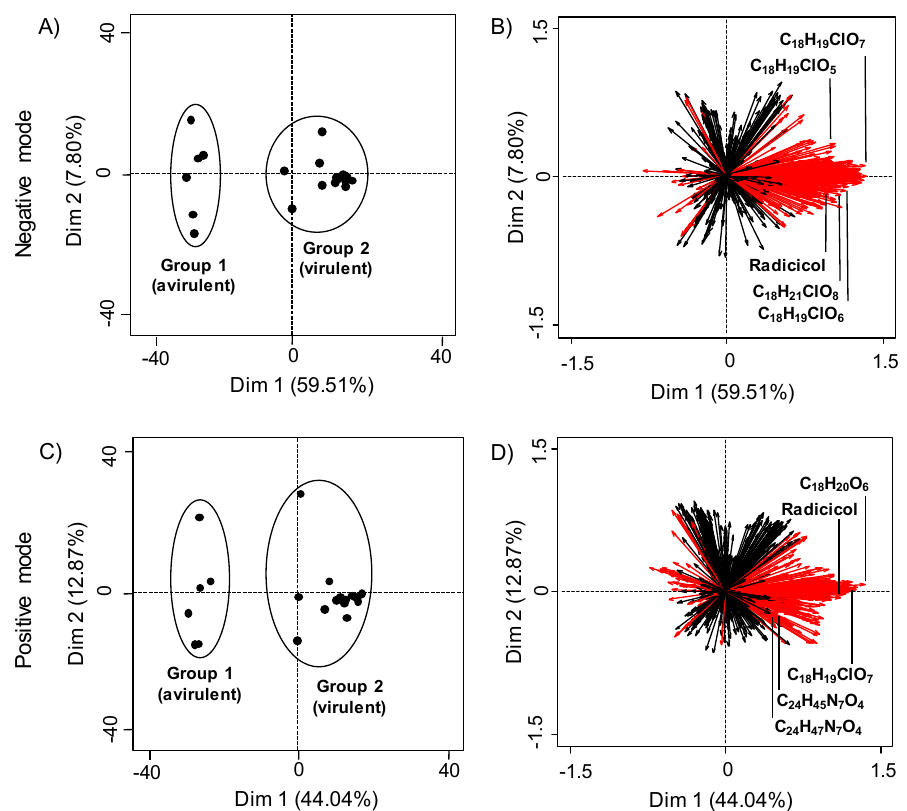
Figure 1. Principal component analysis (PCA) plots of metabolites from Ilyonectria and Neonectria spp. in both positive and negative ionization modes. Plots ( A , C ) show individual samples with group 1 being avirulent strains and group 2 containing virulent strains. Plots ( B , D ) show the factor loadings for samples, with each ray representing an LC-MS feature. Red rays indicate features that significantly contribute to PCA distribution ( p < 0.05 Kruskal-Wallis test with Benjamini-Hochberg p value correction). The five most abundant compounds produced by virulent strains are labeled.